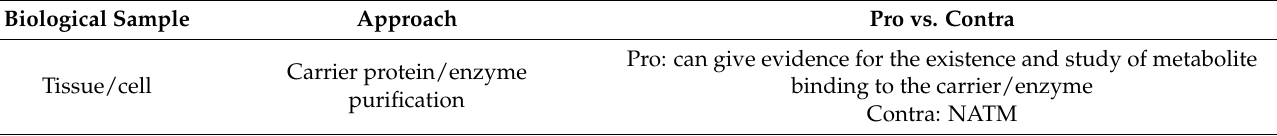
Proteins, lipids Reconstitution study